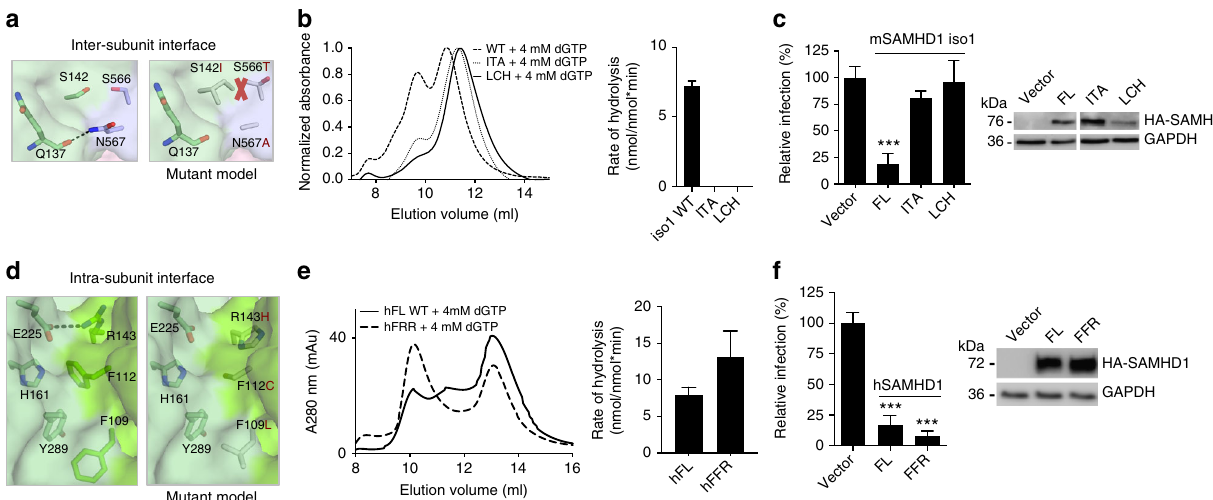
Fig. 3 The importance of SAM-to-HD interactions for mSAMHD1 oligomerization and activities. a , d Left, transparent surface representation of SAM-to-HD interface with important residues shown in sticks. Right, model of SAM-to-HD interface after mSAMHD1 residues are mutated to the corresponding hSAMHD1 residues. The red cross in a indicates a steric clash. b , e Left, SEC analysis of mSAMHD1 ( b ) or hSAMHD1 ( e ) variants before and after incubation with dGTP- α -S. Right, dNTPase assay for wild type and mutant mSAMHD1 proteins ( b ) or hSAMHD1 ( e ). Products were quanti fi ed by the malachite green assay. Each experiment was performed in triplicate. Error bars, s.d. c , f HIV-1 restriction by full-length mSAMHD1 iso1 ( c ) or hSAMHD1 ( f ) (WT and mutants) stably expressed in U937 cells after PMA differentiation. Immunoblotting (uncropped images in Supplementary Fig. 7) con fi rmed HA- tagged mSAMHD1 or hSAMHD1 expression. GAPDH was used as a loading control. Single-cycle HIV-1 infection of vector control cells was set as 100%. Each experiment was performed in triplicate. Error bars, s.d. *** p ≤